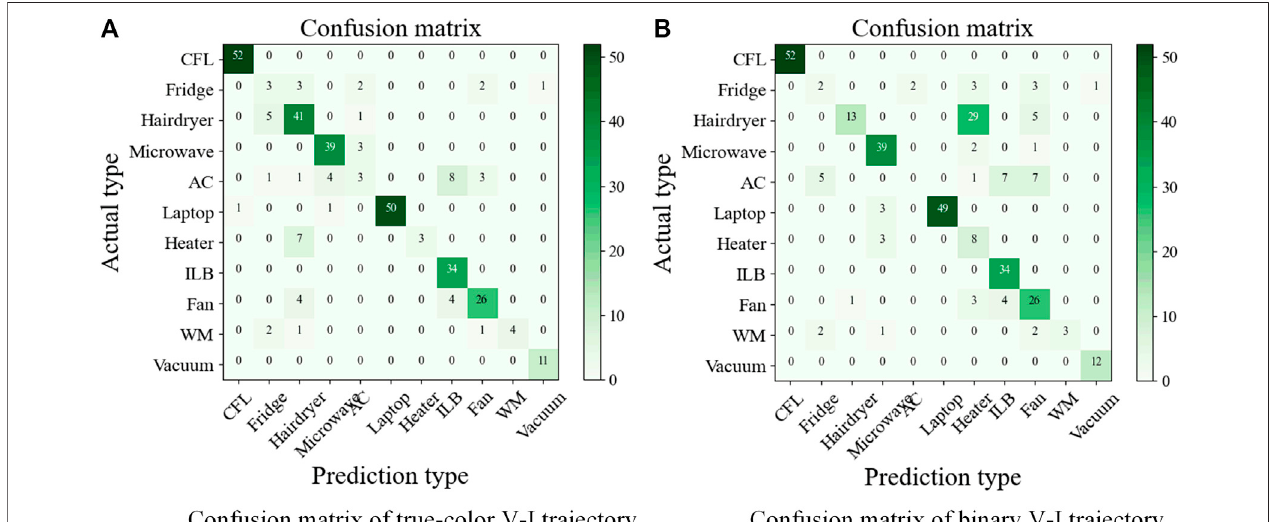
FIGURE 6 | Confusion matrix of compound features.